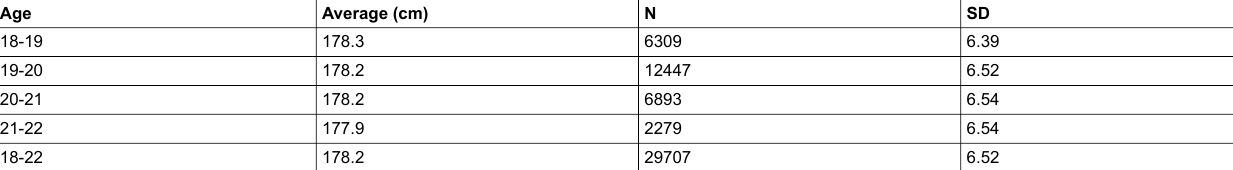
Table 2: Average heights for five one-year age groups (18–22 years) in the conscription year 2009 (N =